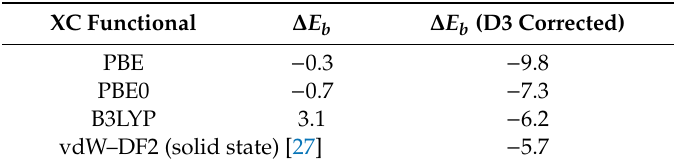
Table 2. Binding energy ( ∆ E b in kJ / mol H 2 ) for H 2 physi-sorption on coronene using di ff erent XC functionals.